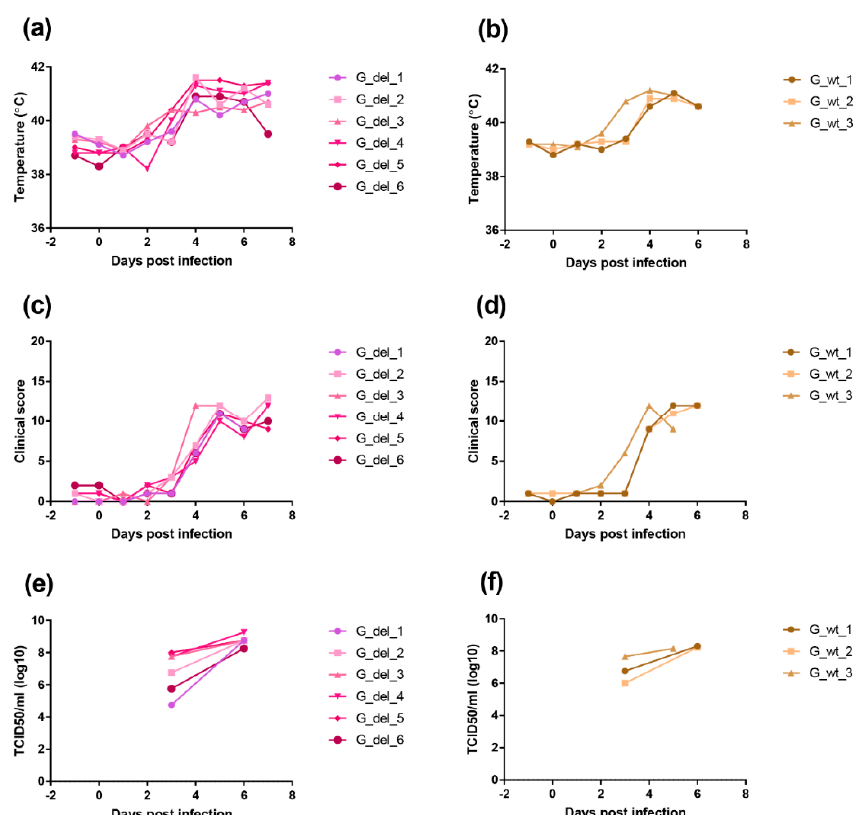
Figure 9. Clinical scores and temperatures of pigs following infection with Georgia Δ I329L or Georgia 2007 / 1 wild type. The panels ( a , b ) show temperatures and panels ( c , d ) clinical scores following infection of pigs with Georgia ∆ I329L (G_del_1 to 6) or Georgia wild type (G_wt_1 to 3). The panels ( e , f ) show TCID 50 per ml of blood (y-axis) at different days post-infection.